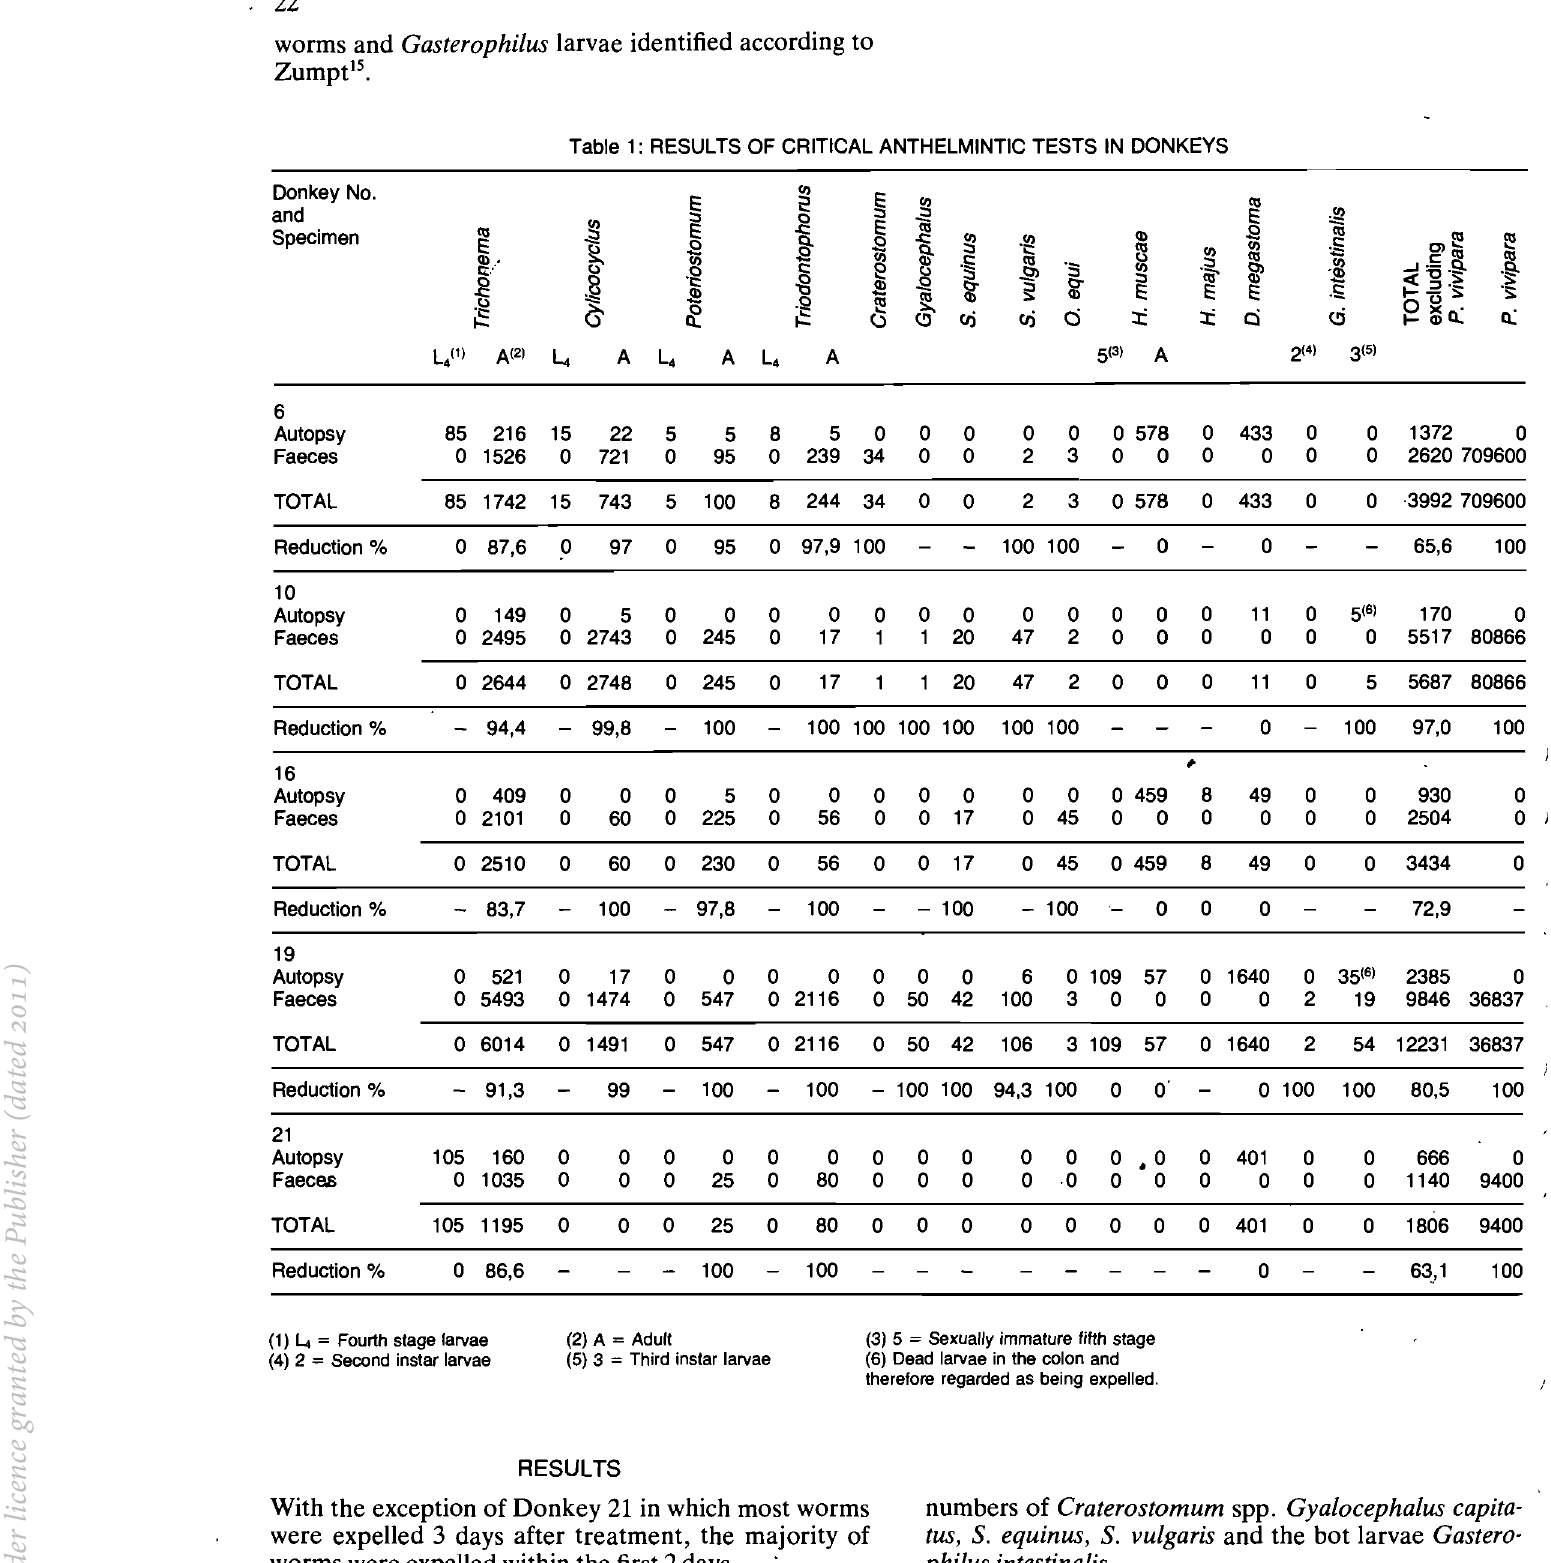
Table 1 : RESULTS OF CRITICAL ANTHELMINTIC TESTS IN